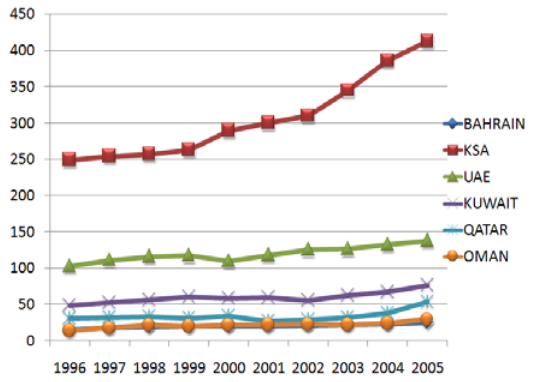
total emissions from consumption of fossil fuel for GCC Figure 2. CO 2